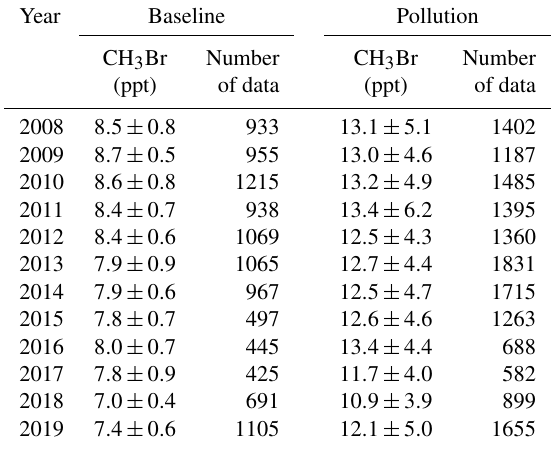
Table 1. Annual means, standard deviations, and the number of data of each CH 3 Br baseline and actual polluted signals at Gosan from 2008 to 2019 that are represented in Fig. 2.